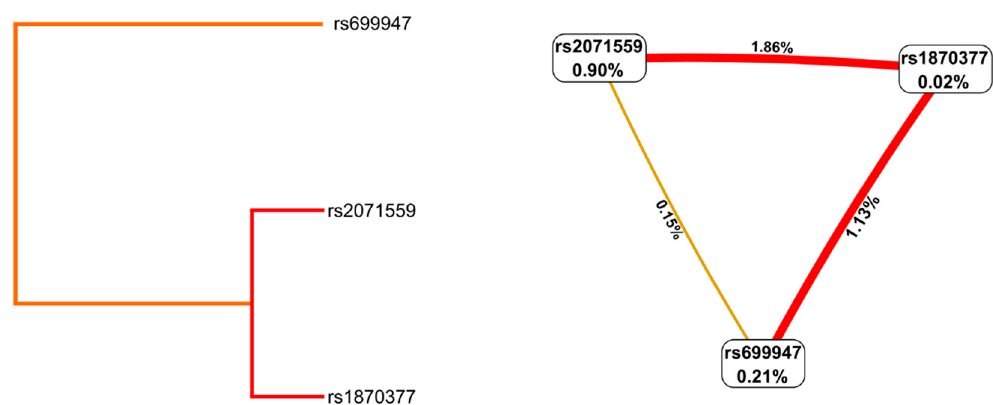
Figure 2. SNP–SNP interaction dendrogram and Fruchterman–Reingold plots obtained by multifactor dimensionality reduction for genes encoding angiogenesis related factors in infertility.